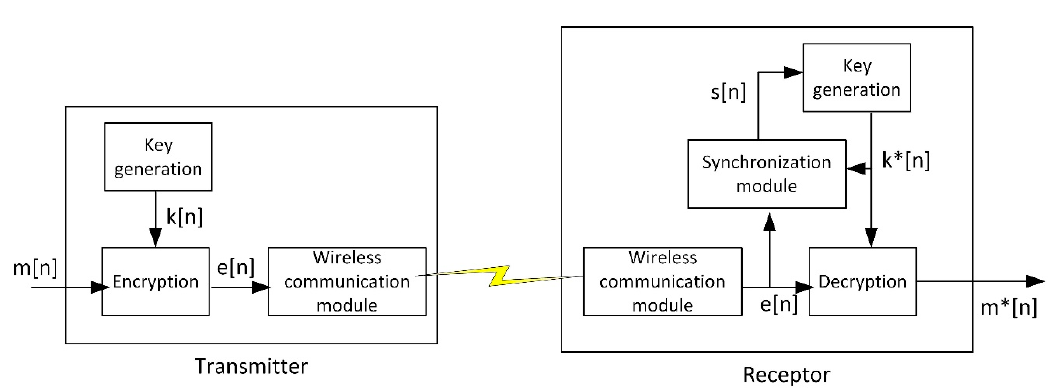
Figure 1. Global overview of the proposed solution.